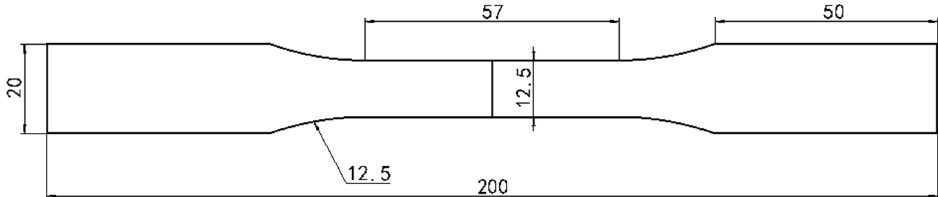
Figure 2. Dimensions of the tensile sample.